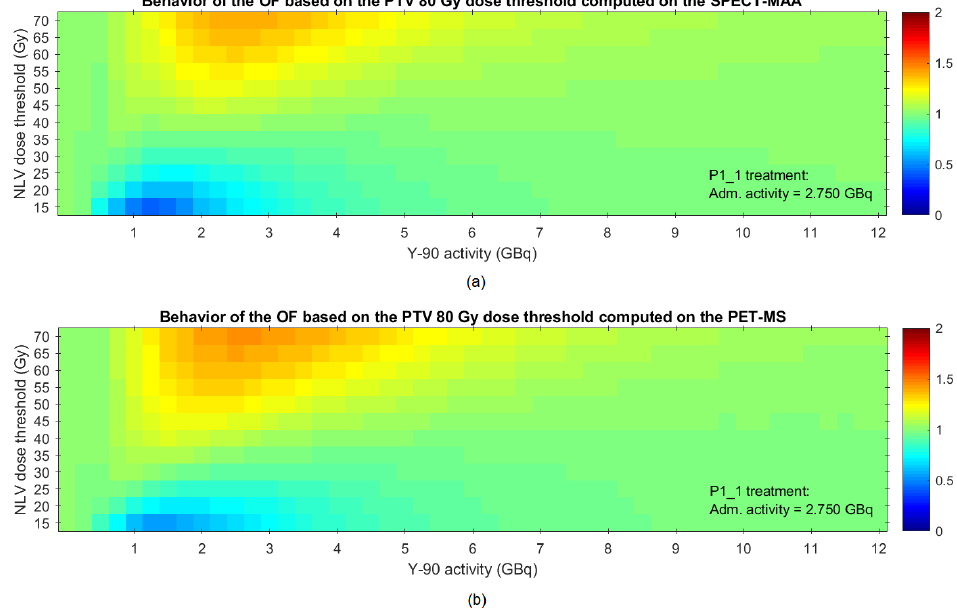
Figure 7. Distributions of the OF for P1_1 case, based on PTV 80 Gy AD threshold and twelve NLV AD thresholds (15 Gy – 70 Gy) considering activities between 0 and 12 GBq, computed on the SPECT-MAA ( a ) and PET-MS ( b ) ADD. The administered activity was 2750 MBq, and the estimated optimal activity was 2598 MBq (based on the treatment planning SPECT-MAA).